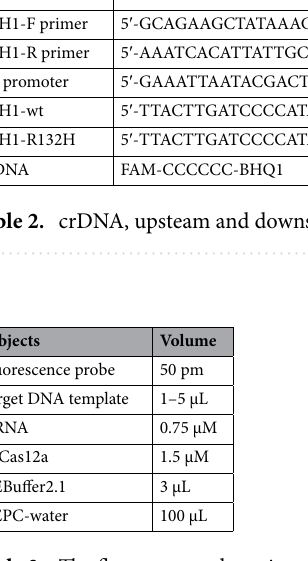
Table 3. The fluorescence detection system of